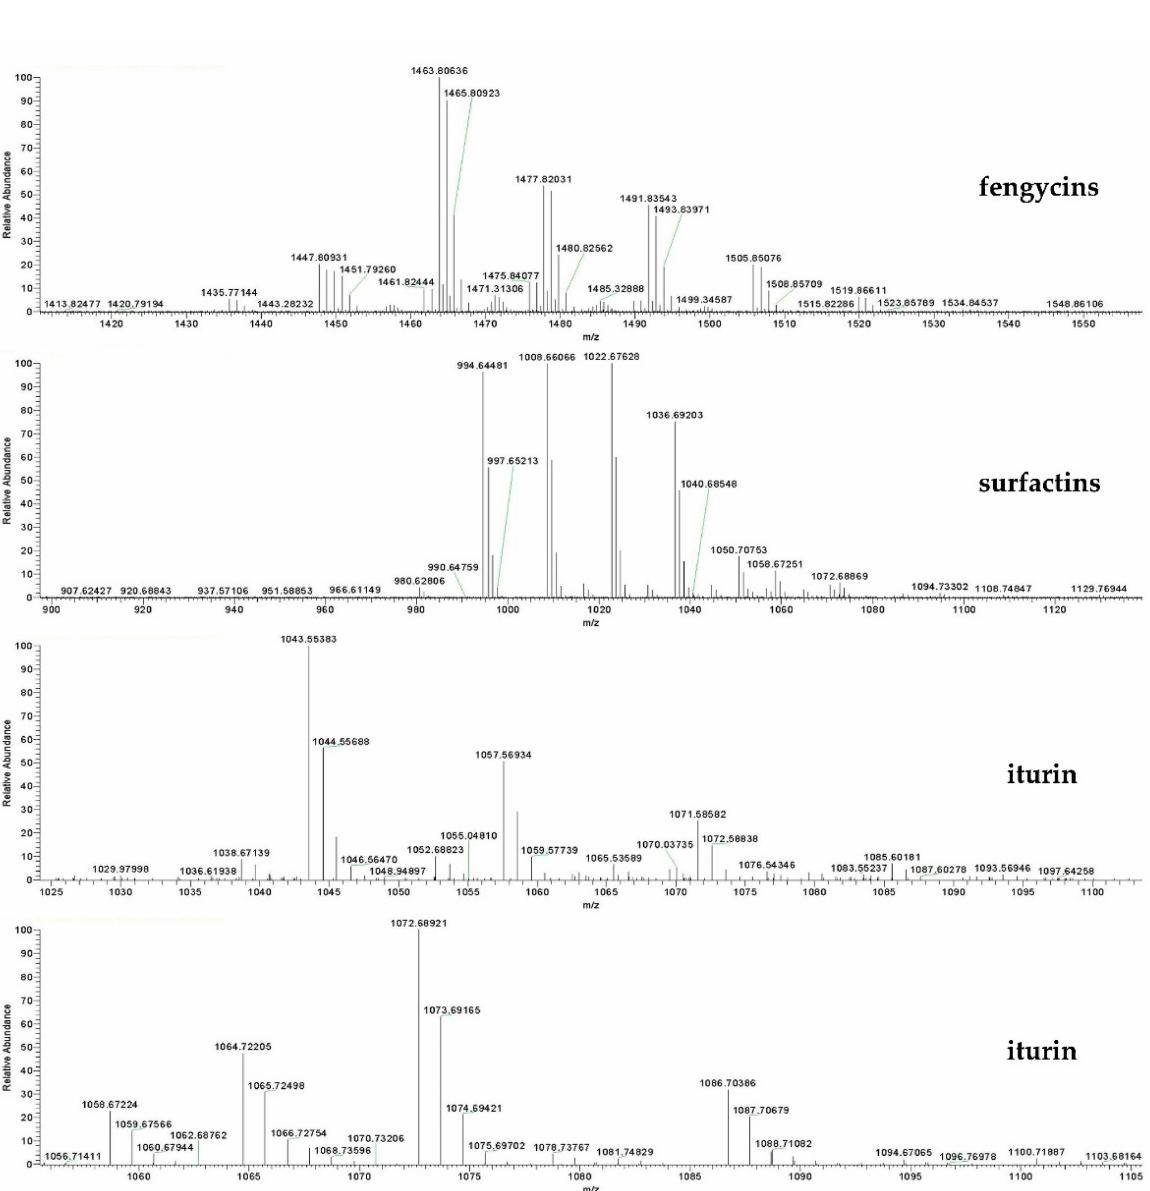
Figure 7. Identification and quantification of lipopeptide compounds from strain F9 and FZB42. Identification of lipopeptide compounds from the acetone extract of strain F9 using HPLC–MS analysis. Mass spectra [M + H] + of LPs are shown. The representative chromatograms of the lipopeptides (iturin, fengycin and surfactin) in acetone extract (3 µ L) from strain F9 were used for HPLC–MS